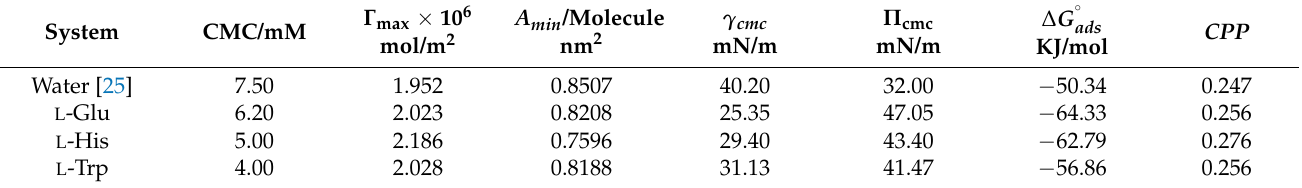
Table 2. Values of the CMC, maximum surface excess concentration, minimum occupied area per surfactant molecule, surface tension at CMC, surface pressure at CMC, Gibbs free energy of adsorption and, packing parameter of SDS in the presence and absence of 0.01 M amino acid at 20 ◦